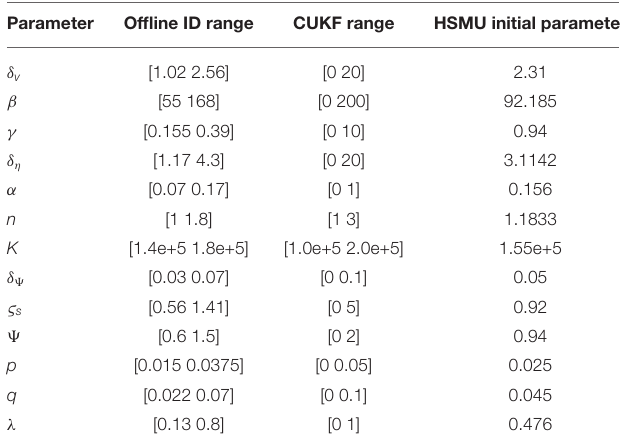
TABLE 1 | Model parameters of Bouc-Wen model.